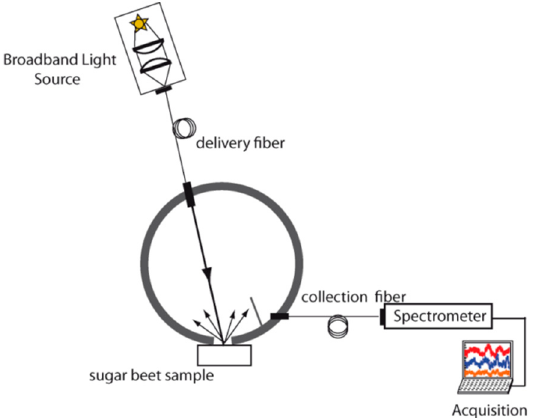
Figure 1. Schematic diagram of integration sphere setup.